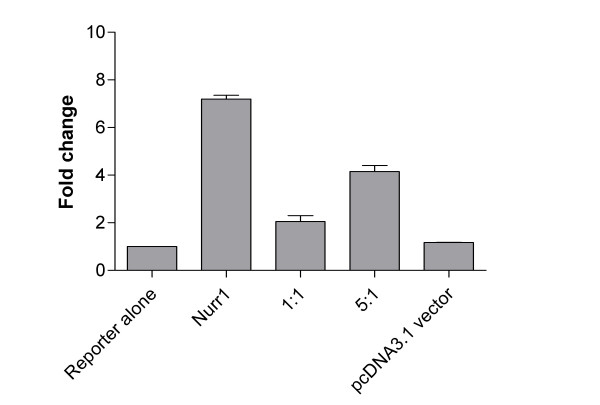
Coexpression of a dominant negative-Nurr1 receptor attenuates the transactivation activity of Nurr1-wild type in a β-Gal reporter assay. HeLa cells coexpressing pCDNA3.1-Nurr1-WT and pcDNA3.1-Nurr1-DN in varying ratios demonstrates strong antagonist effects of dominant negative Nurr1 construct on Nurr1 transcriptional activity (pNurRE3gal), values normalised to cotransfected hGH, using an hGH sandwich ELISA assay. Values expressed represent the mean fold change ± SEM, compared to the reporter alone.